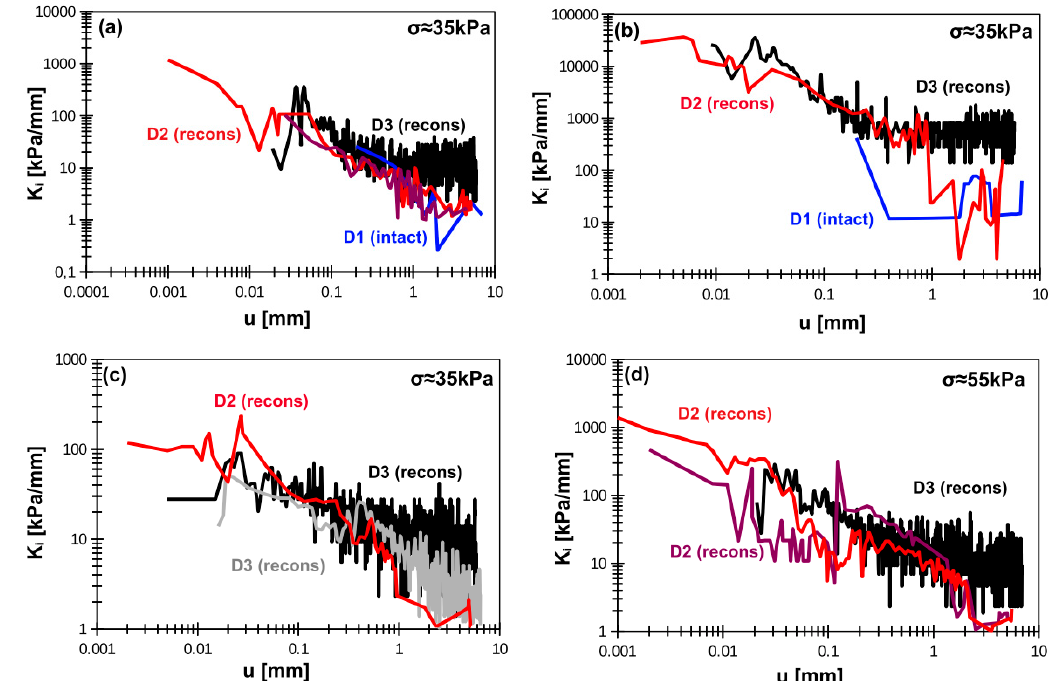
Figure 7. Smooth concrete–soil interface stiffness degradation for ( a ) silty loam, ( b ) organic clay, ( c ) peat, ( d ) organic silt. Note: D1, D2, D3 indicate device type; intact = intact sample, recons = reconstituted sample.